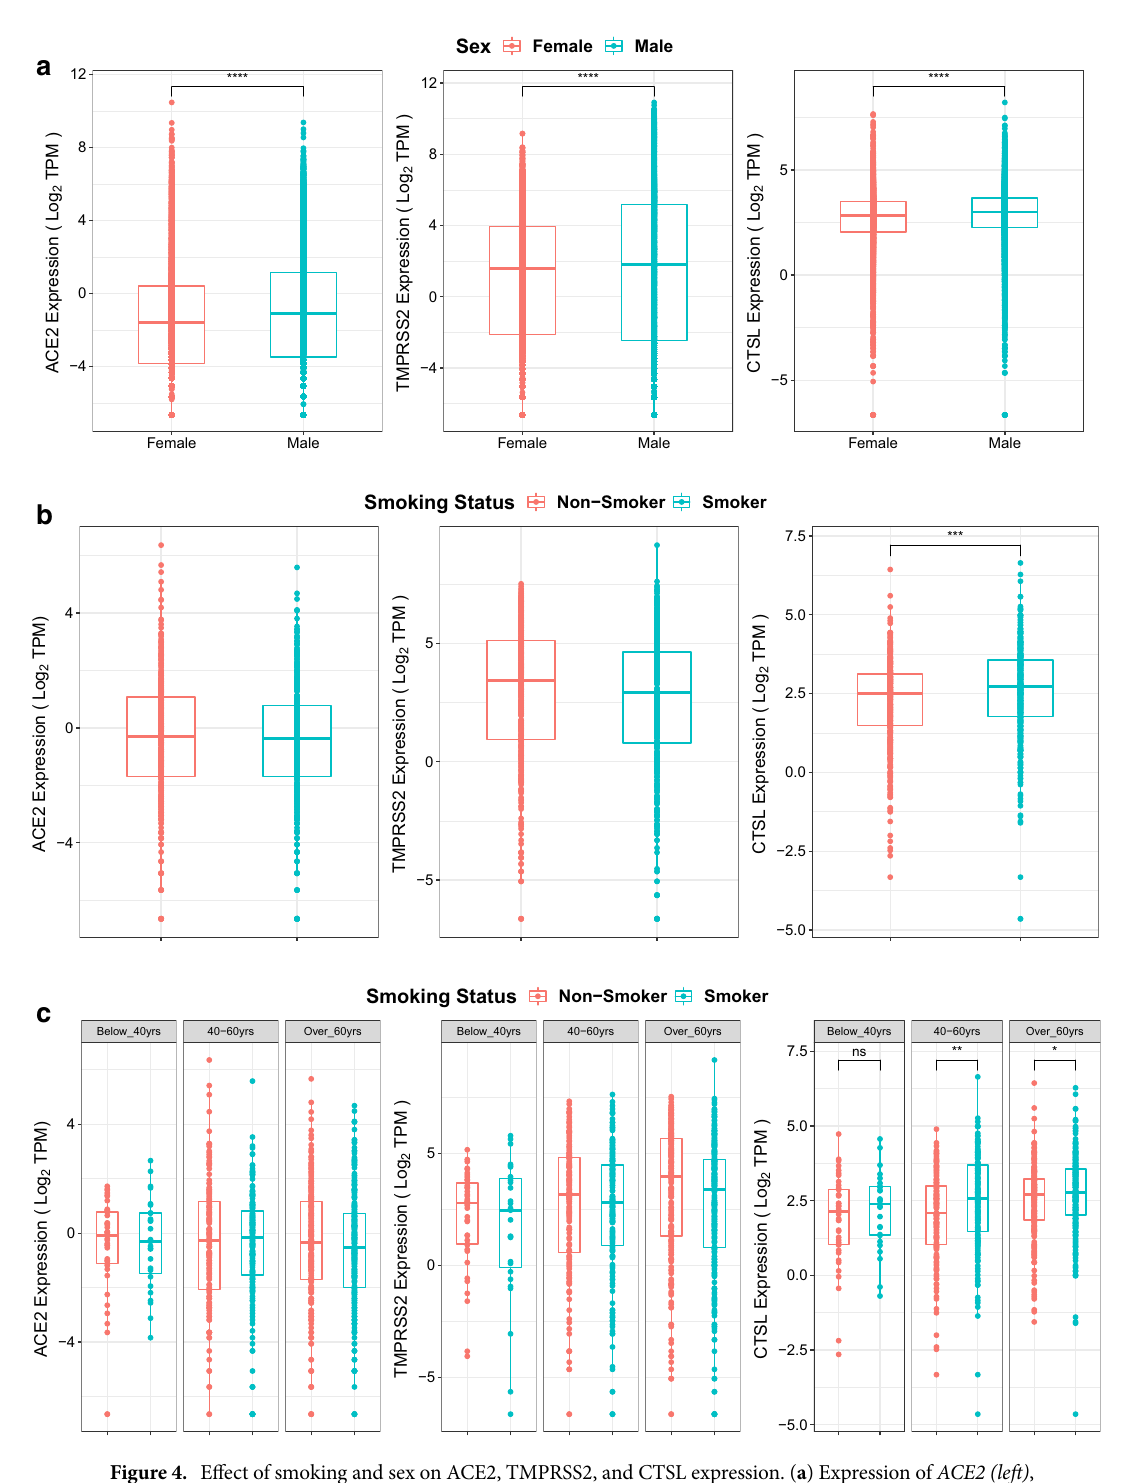
Figure 4. Effect of smoking and sex on ACE2, TMPRSS2, and CTSL expression. ( a ) Expression of ACE2 (left) , TMPRSS2 (middle) , and CTSL (right) in TCGA data for males and females for 33 cancer types (n = 12,736) with available annotations in TCGA. Wilcoxon signed rank tests were performed and significant differential expression between groups was labelled **** p < 0.0001 between males and females. ( b ) Expression of ACE2 (left) , TMPRSS2 (middle) , and CTSL (right) in TCGA data for non-smokers and smokers with lung squamous cell carcinoma, lung adenocarcinoma, cervical cancer, bladder urothelial carcinoma or esophageal carcinoma (n = 873). Wilcoxon signed rank tests were performed and significant differential expression between groups was labelled. *** p < 0.001 between non-smokers and smokers. ( c ) Expression of ACE2 (left) , TMPRSS2 (middle) , and CTSL (right) in TCGA data for non- smokers and smokers with lung squamous cell carcinoma, lung adenocarcinoma, cervical cancer, bladder urothelial carcinoma or esophageal carcinoma split into age groups: below 40 years (n = 68), between 40 and 60 years (n = 328), above 60 years (n = 477). Wilcoxon signed rank tests were performed and significant differential expression between groups was labelled * p < 0.05; ** p < 0.01 between non-smokers and